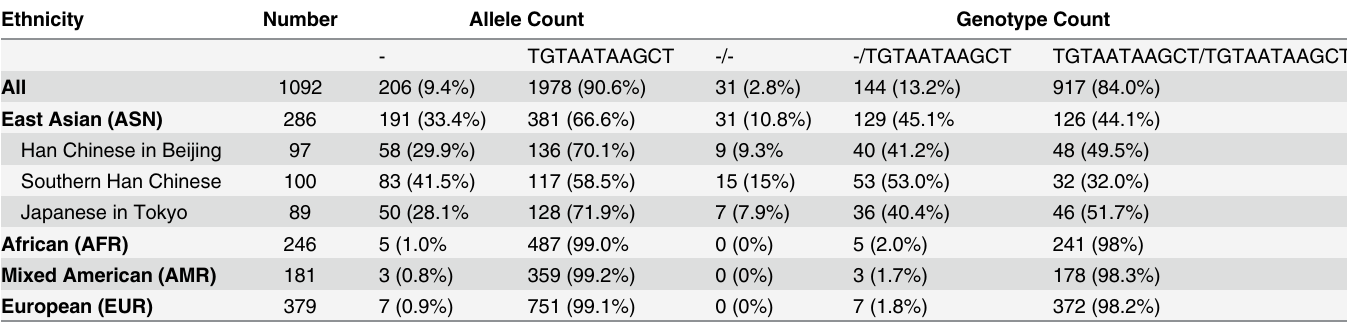
Table 3. Alleles and Genotypes with Their Frequencies of Del -100~-110 in 1092 People Worldwide in the “ 1000 Genomic Project ” .